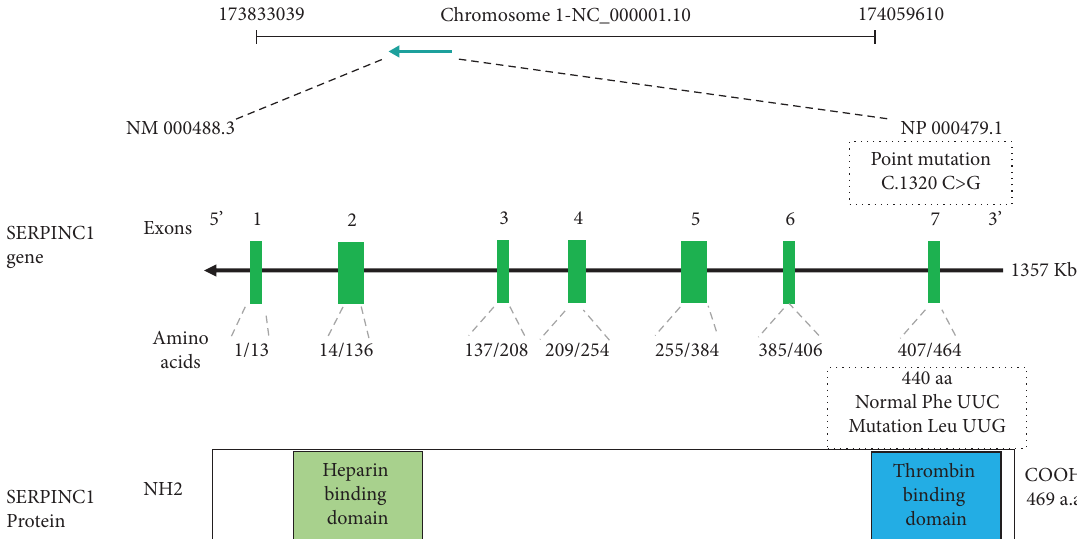
Figure 1: Te SERPINC1 gene and protein domain structures. Te fgure showed gene ID 462 SERPINC1 as well as merged features of NP_000479.1 and NM_000488.3 with 1357kb. Te SERPINC1 gene shown by a heavy horizontal arrow line represents genomic DNA. Exons are shown as vertical green bars and numbered from 1 to 7. Te amino acids encoded by each exon are indicated below the vertical green bars and are numbered from 1 to 464. Te SERPINC1 protein structure showed two main domains: the NH 2 -terminal heparin-binding domain encoded by exon 2 and a COOH-terminal thrombin- (serine protease-) binding domain. Te patient point mutation is indicated by red colour in the dotted box at exon 7 (c.1320C > G); also, the result of this mutation is indicated on 440 a.a which leads to produced Leu (leucine) instead of Phe (phenylalanine) (adapted from [9,